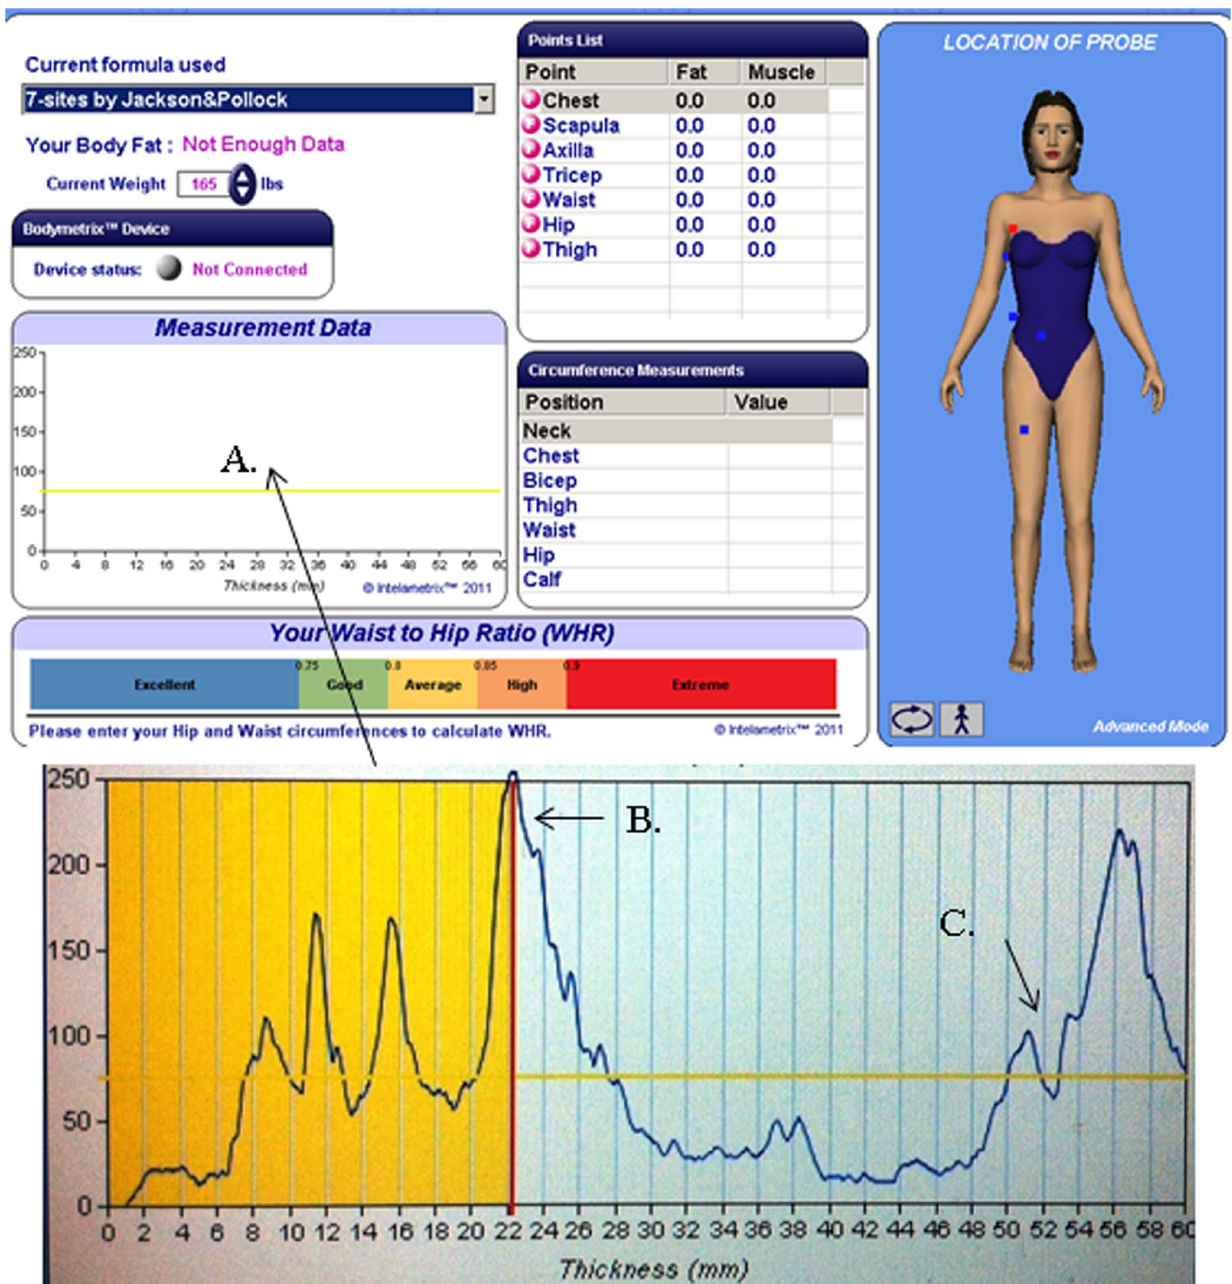
Figure 1. Image of the tissue boundaries and corresponding amplitudes produced from the proprietary software. Amplitudes appear within measurement data section (A). With a minimum of two measurements averaged. The fat-muscle boundary is illustrated at the first peak (B). Artifact within the muscle is demonstrated by other peaks (C).